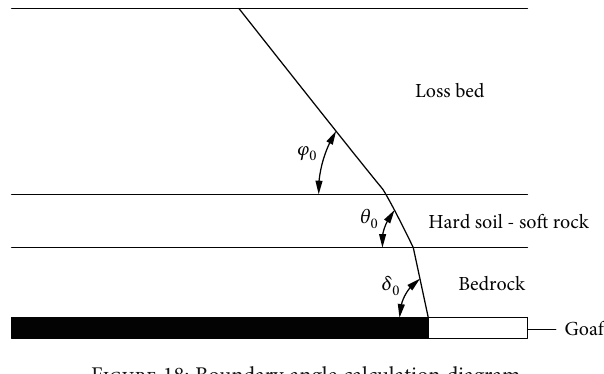
Table 4: Learning sample